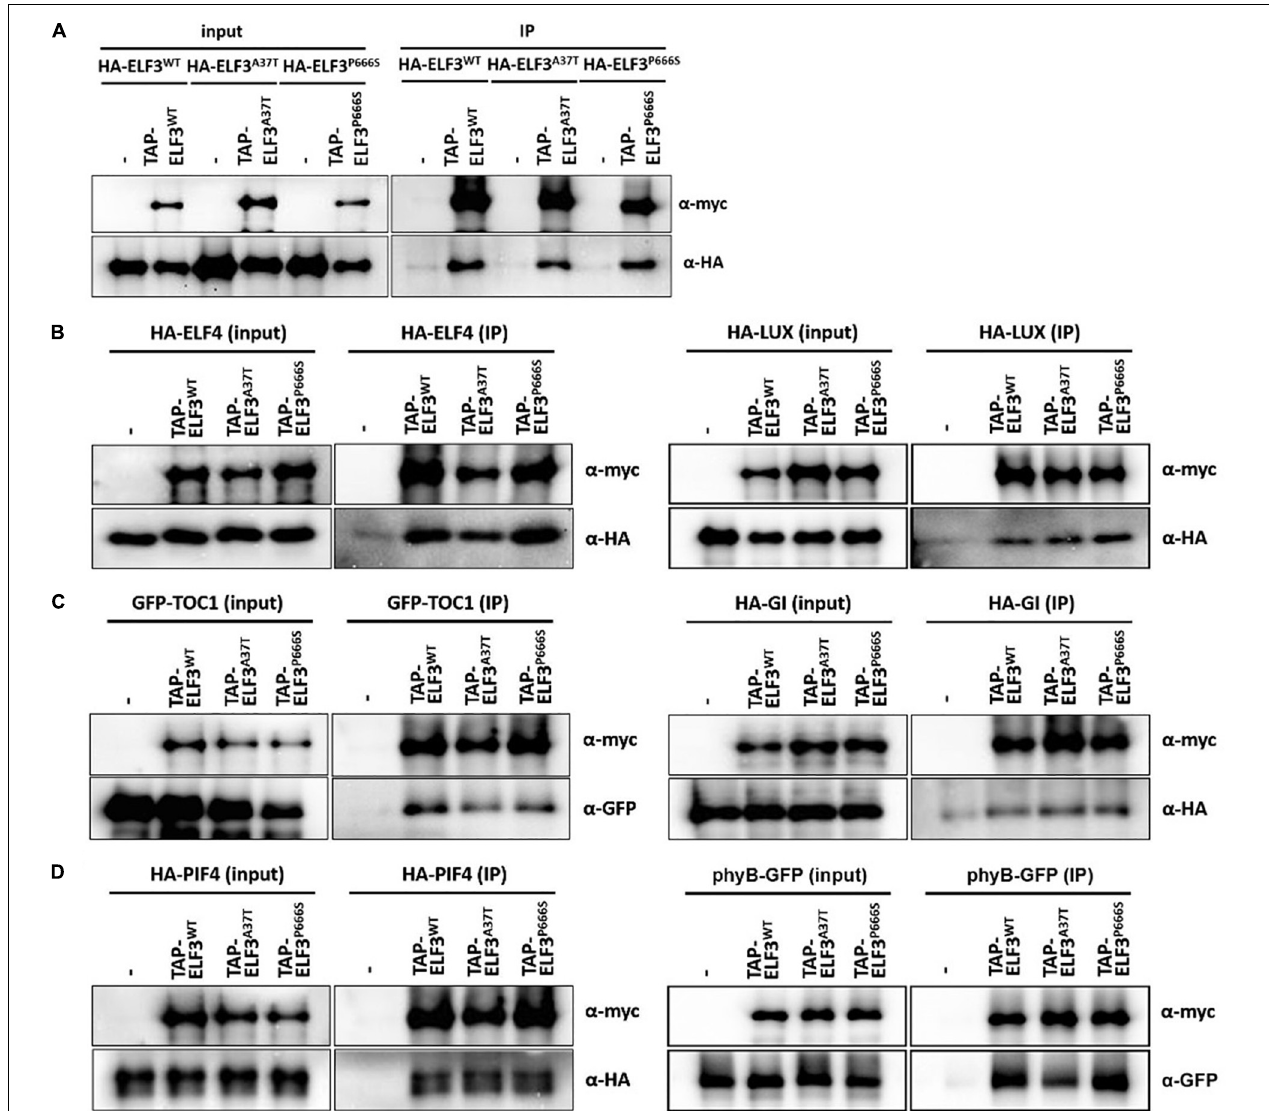
FIGURE 8 | Interaction of elf3 mutant alleles with select known interaction partners. TAP-ELF3 WT , TAP-ELF3 A37T (elf3-14), and TAP-ELF3 P666S (elf3-13) proteins were co-expressed with either ELF3, ELF4, LUX, PIF4, phyB, GI, or TOC1, tagged with HA or GFP, in N. benthamiana . Infiltrated leaves were processed, total proteins were immunoprecipitated (human IgG) and precipitates were probed for the appropriate partner. (A) Homodimerization of ELF3 alleles. (B) Interactions with EC partners. (C) Interactions with TOC1 and GI. (D) Interactions with PIF4 and phyB. Representative immunoblots from two to three biological trials. Quantitation of these interactions are shown in Supplementary Figure S3